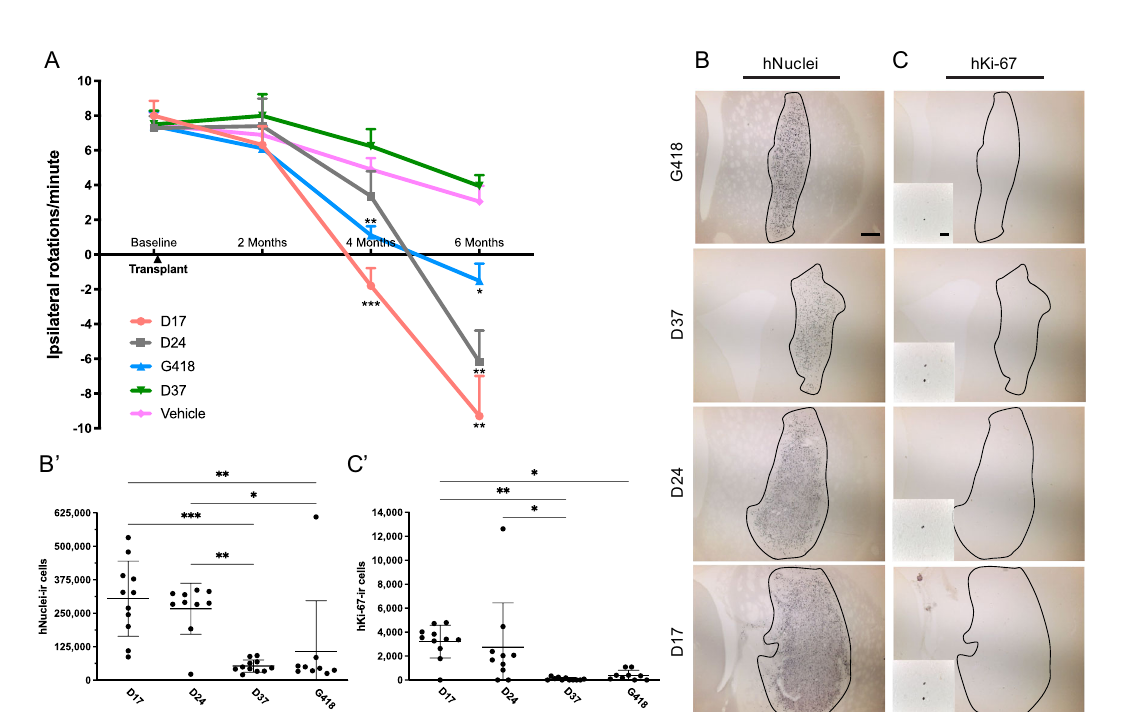
Fig. 3 Graft survival and function. Time-based analysis of A d-amphetamine-induced rotations measured pre-operatively and at 2, 4, and 6 months post-engraftment. At 4 months post-transplantation, P < 0.0005 for D17 and P < 0.005 for G418; at 6 months post-transplantation, P < 0.0005 for D17 and D24 and P < 0.05 for G418. Data were analyzed by mixed ANOVA with Tukey ’ s adjustment; error bars are SEM. Comparisons were made to vehicle group. Representative graft sections stained for B hNuclei and C hKi-67 with graft borders indicated by black outline. Quanti fi cation by unbiased stereology of B ’ hNuclei-ir ( P < 0.0001 D17 vs. D37/G418; P < 0.0005 and P < 0.005 for D24 vs. D37/ G418, respectively) and C ’ hKi-67-ir cells ( P < 0.05 for D17 vs. D37; P < 0.01 for D17 vs. G418; P < 0.05 for D24 vs. D37). Scale bar = 500 μ M in B ; 50 μ M in C (inset). hNuclei estimates were analyzed by one-way ANOVA with Tukey ’ s adjustment; error bars represent SD. hKi-67 estimates were analyzed by Kruskal – Wallis test and Dwass – Steele – Critchlow-Fligner post hoc. * p < 0.05 ** p < 0.001 *** p <